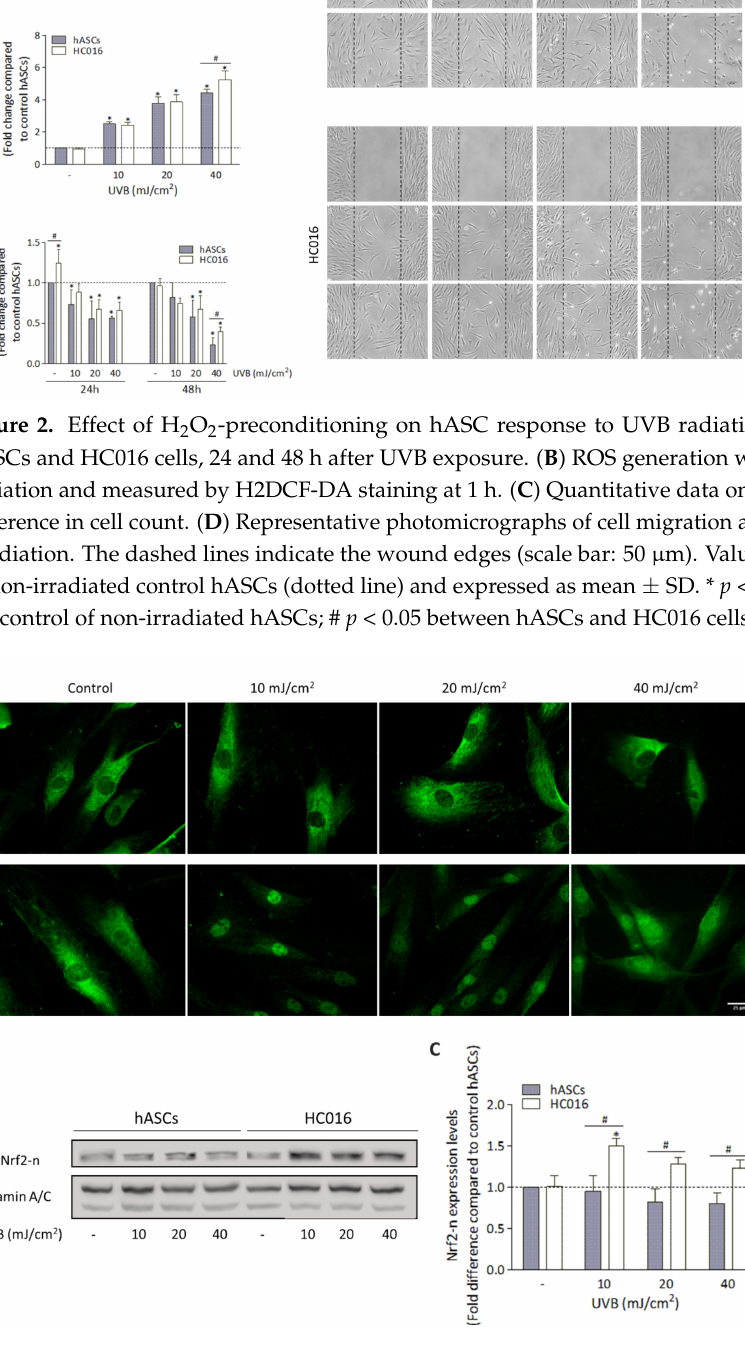
Figure 3. H 2 O 2 -preconditioning increases the expression of Nrf2-n. ( A ) Representative images of Nrf2 intracellular localization evaluated by immunofluorescence (scale bar: 25 µ m). ( B ) Western blot analysis of Nrf2-n expression and ( C ) optical density quantification. Values were normalized to non-irradiated control hASCs (dotted line) and expressed as mean ± SD. * p < 0.01 with respect to the control of non-irradiated hASCs; # p <0.05 between hASCs and HC016